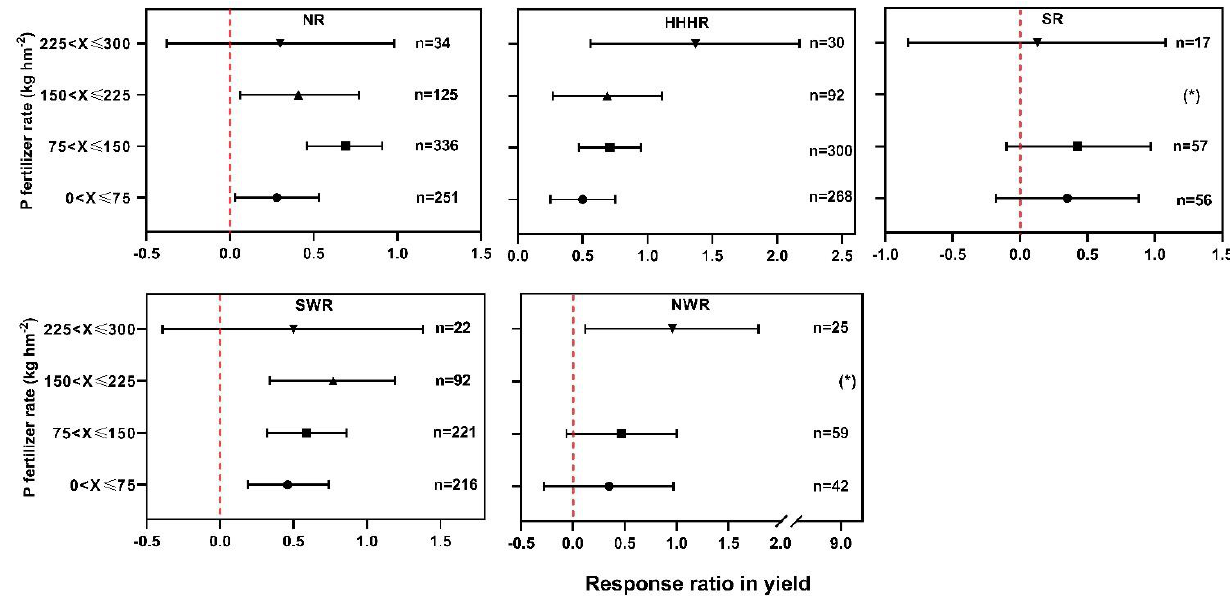
Figure 7. The effect of P fertilization levels on maize yield in each geographic region. NR: Northern region; HHHR: Huang − Huai − Hai region; SR: Southern region; SWR: Southwestern region; NWR: Northwestern region. The error lines indicate the 95th percentile bootstrap confidence intervals, whereas n values represent the corresponding number of observations (total number of control and treatment values). (*) indicates that a subgroup has an n lower than nine. Yield with P fertilization is a treatment value, whereas yield without P fertilization is a control value.